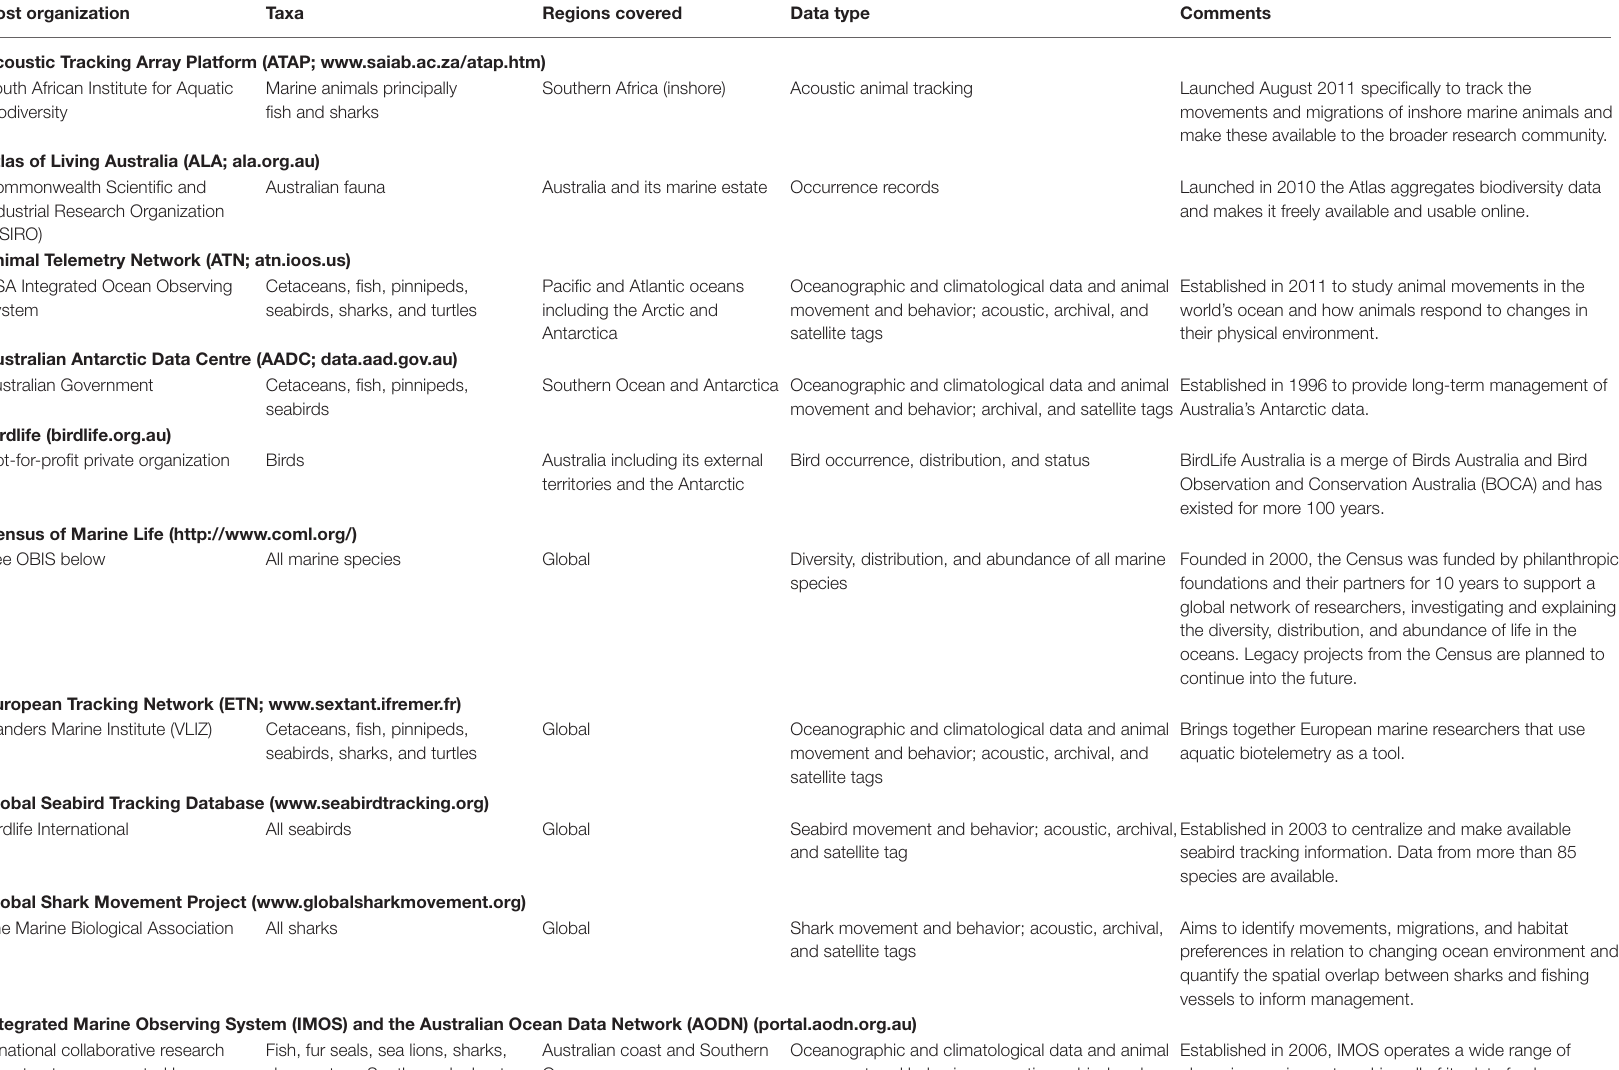
TABLE 1 | Summary of marine data repositories for animal-borne oceanographic sensors and observation of animal